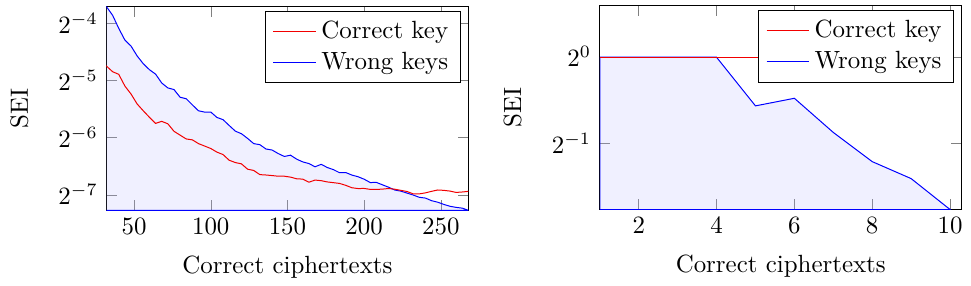
Figure 4: Attacks on 8-bit software AES, detection countermeasure. SEI of the correct key (SEI R ) vs. best SEI for a wrong key (SEI ∗